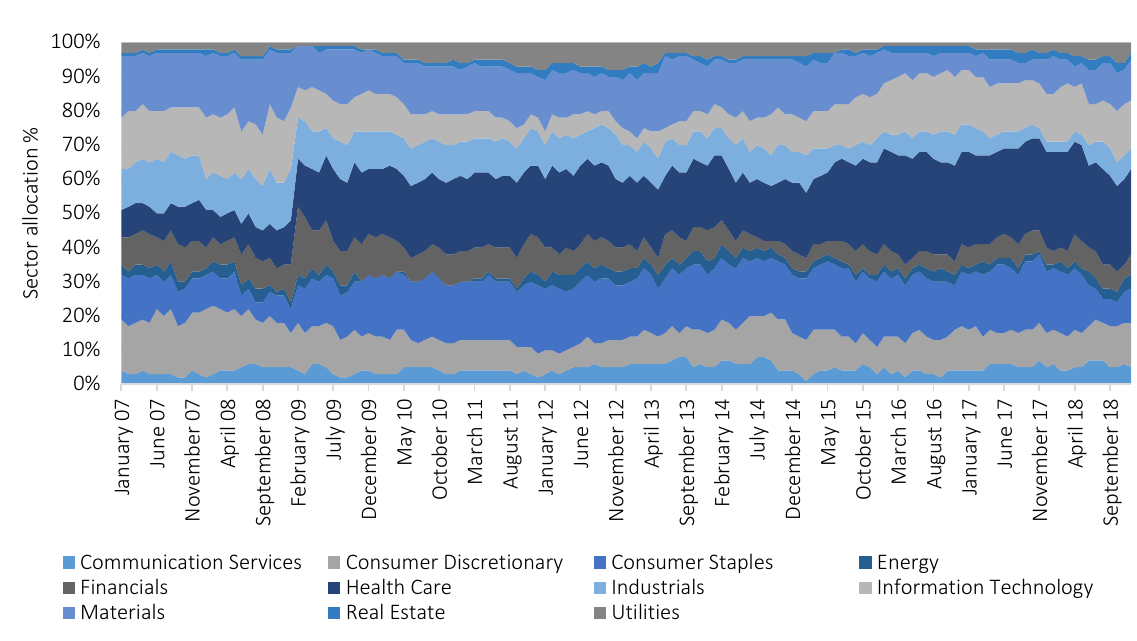
Figure 1b. Beta sorted low-risk portfolio sector